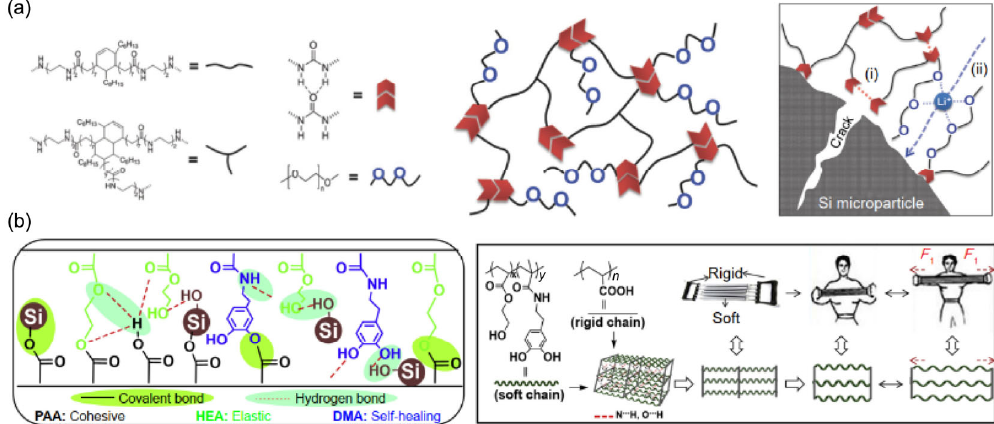
Figure 8 (a) Schematic chemical structure of the SHP-PEG binder and schematic illustration of the Si microparticle electrode with SHP-PEG binder. Left: Self-healing based on dynamic hydrogen bonding close to a crack caused after cycling. Right: Li-ion conduction facilitated by PEG groups. Reproduced with permission from Ref. [142], © WILEY-VCH Verlag GmbH & Co. KGaA, Weinheim 2018. (b) Structural formulae of copolymers and their interaction with Si, chemical structures and illustrative interaction of P(HEA-co-DMA) and PAA. Reproduced with permission from Ref. [143], © Elsevier Inc.